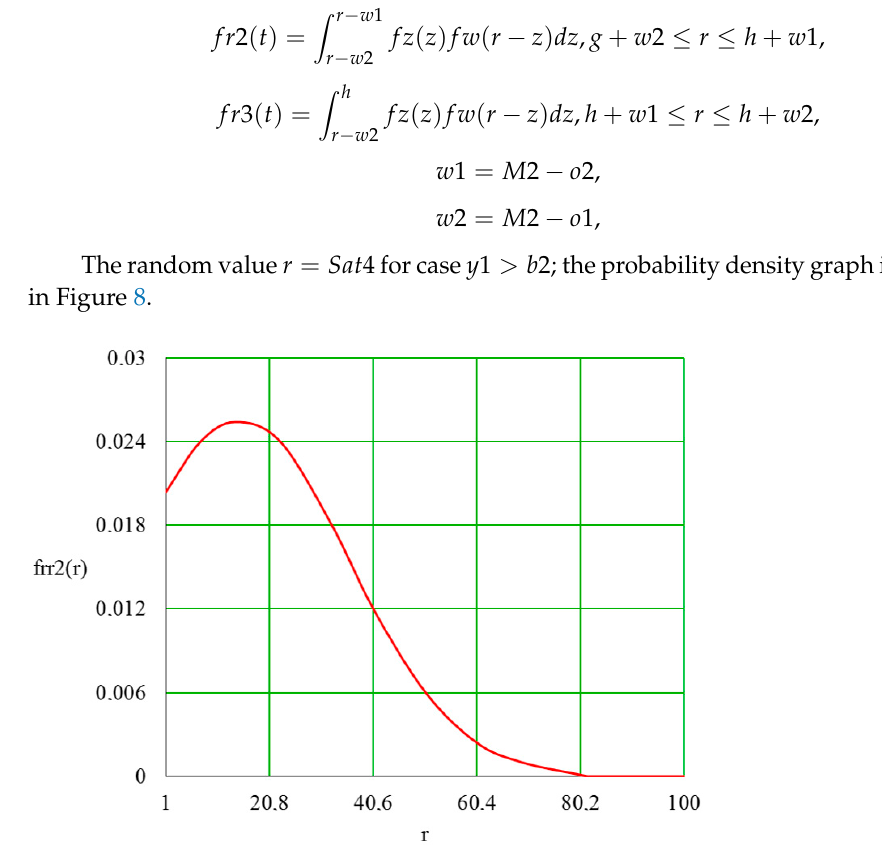
Figure 8. The labor satisfaction (Sat4) probability density ( 𝑦1 > 𝑏2 ).